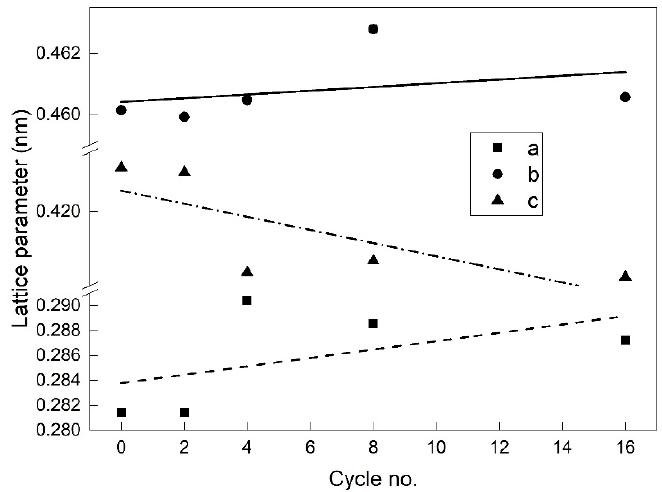
Figure 11. Variation in unit cell parameters of B19 ′ monoclinic martensite determined with the XRD patterns from Figure 9b recorded on concave surfaces as a function of the number of FR-SME training cycles. Experimental values with symbols and linear fits with lines.